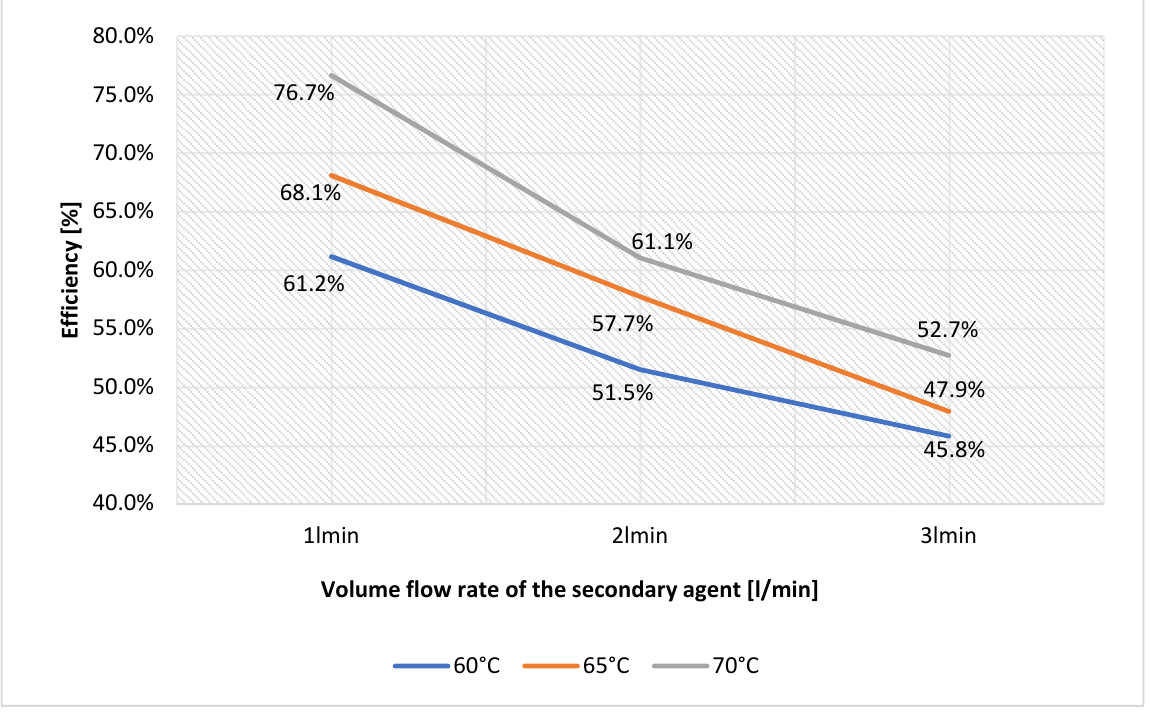
Figure 10. The efficiency of the heat recovery system.